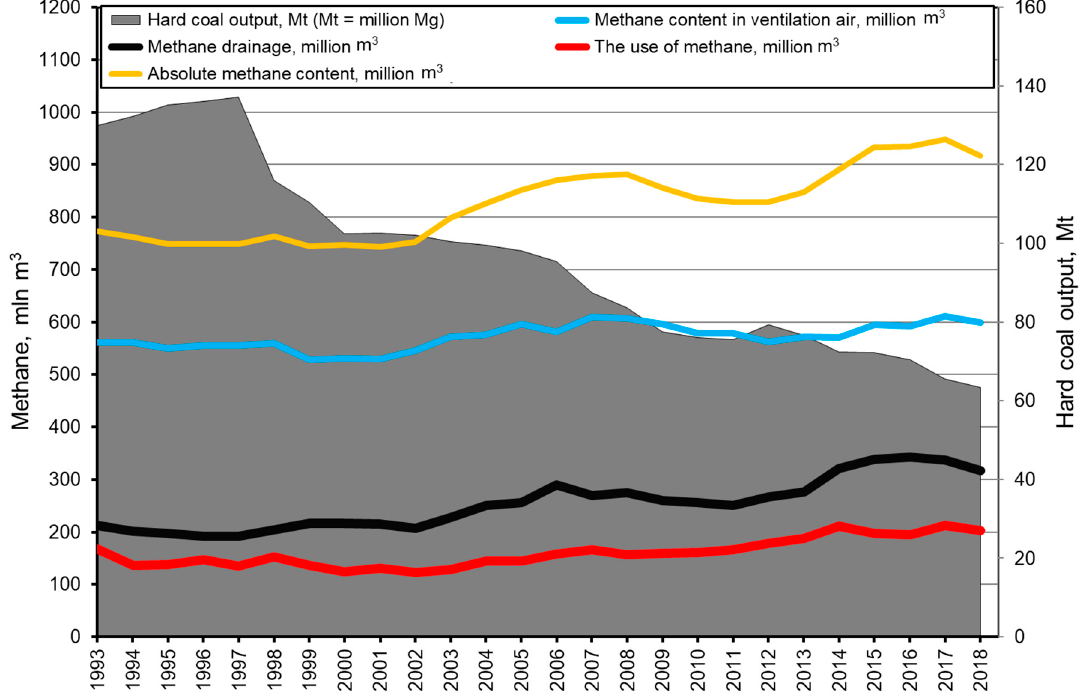
Figure 1. The amount of methane released and captured by the methane drainage system in Polish hard coal mines (own study based on [17]).